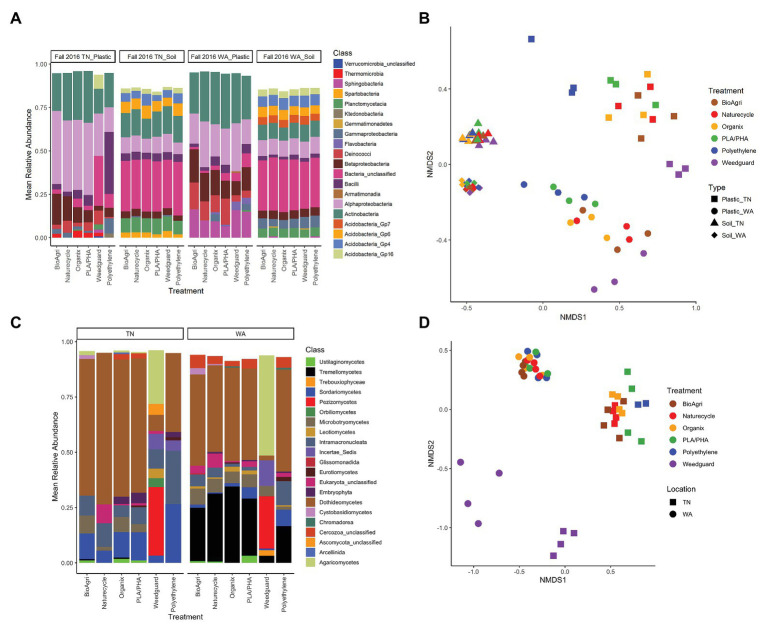
(A) Bacterial taxa distribution (class level) on agriculturally-weathered plastics and bulk soil (Fall 2016) for TN and WA. Mean relative abundances above a cut-off level of 2% are indicated. “Bacteria unclassified” denote taxa with relative abundance above the cut-off level of 2%, but that could not be classified. (B) NMDS ordination of bacterial communities on agriculturally-weathered BDMs and bulk soil in TN and WA (Fall 2016). NMDS stress value: 0.12. (C) Eukaryotic taxa distribution (class level) on agriculturally-weathered plastics (Fall 2016) for TN and WA. Relative abundances above a cut-off level of 2% are indicated. “Eukaryota_unclassified” denote taxa with relative abundance above the cut-off level of 2%, but that could not be classified. Phylum level classification for class incertae_sedis was Mucoromycota for polyethylene, and Chytridiomycota for Weedguard. (D) NMDS ordination of eukaryotic communities on agriculturally-weathered BDMs in TN and WA (Fall 2016). NMDS stress value: 0.18.